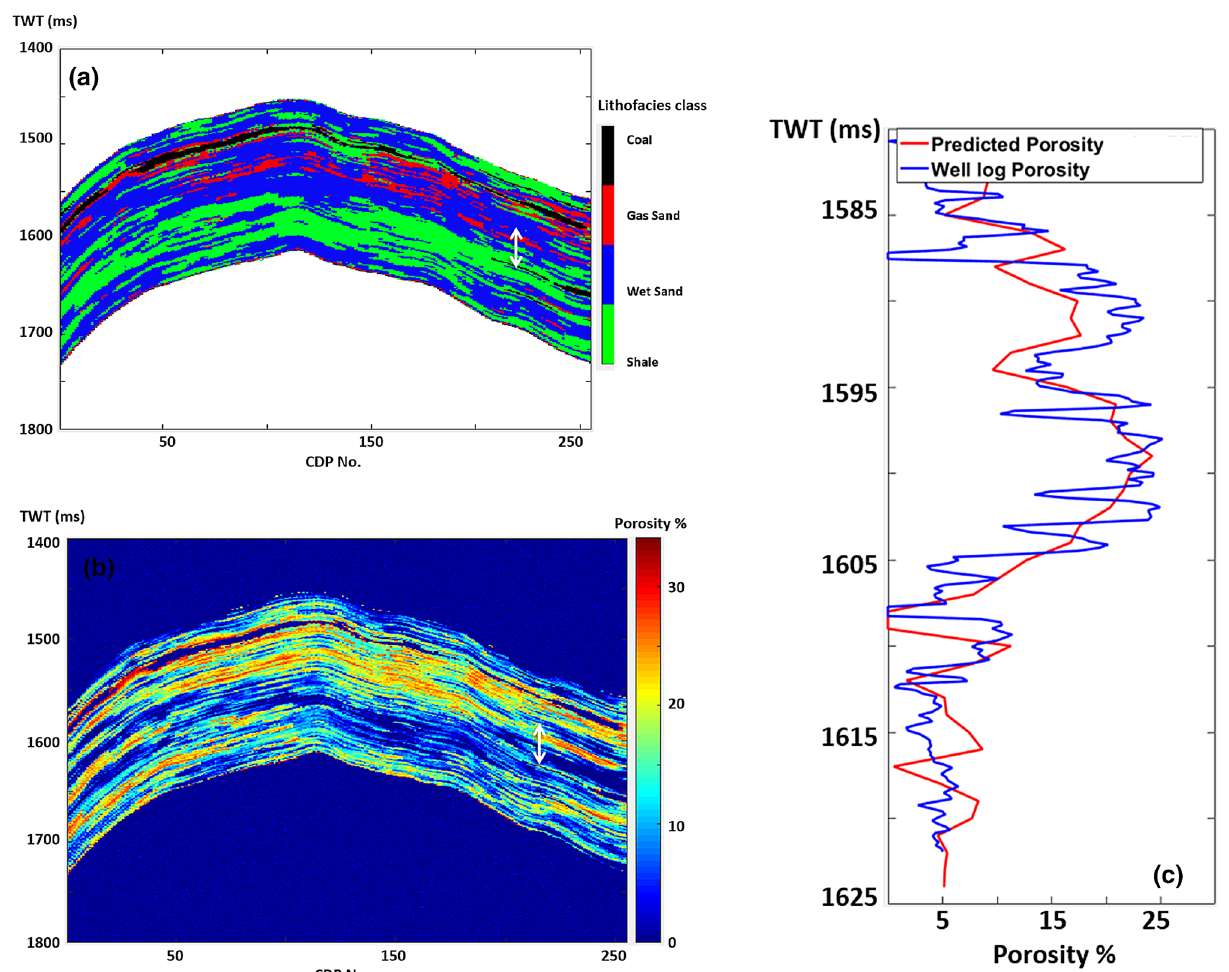
Fig. 6 a Cross section of lithofacies classification. b Cross section of predicted porosity using petrophysical seismic inversion method and c well log porosity superimposed on predicted porosity using petro-